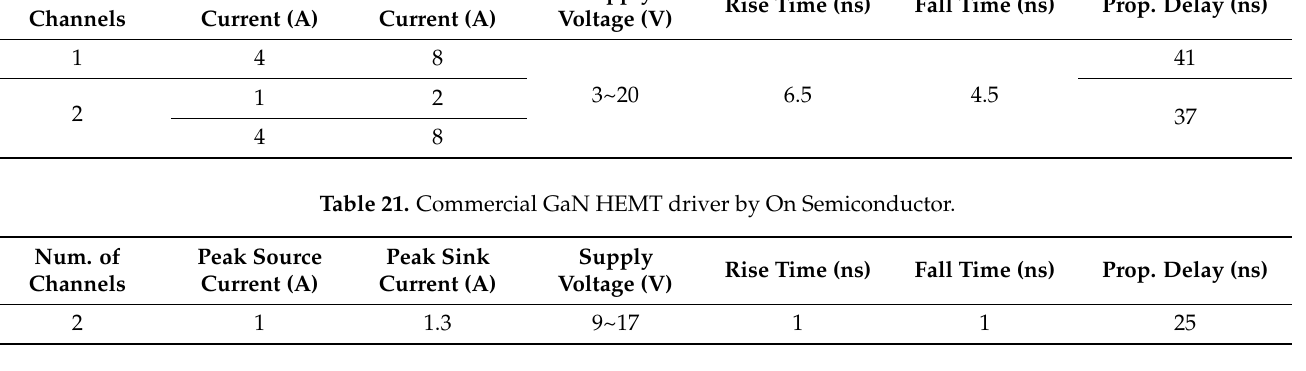
Table 22. Commercial GaN HEMT drivers by Maxim Integrated.